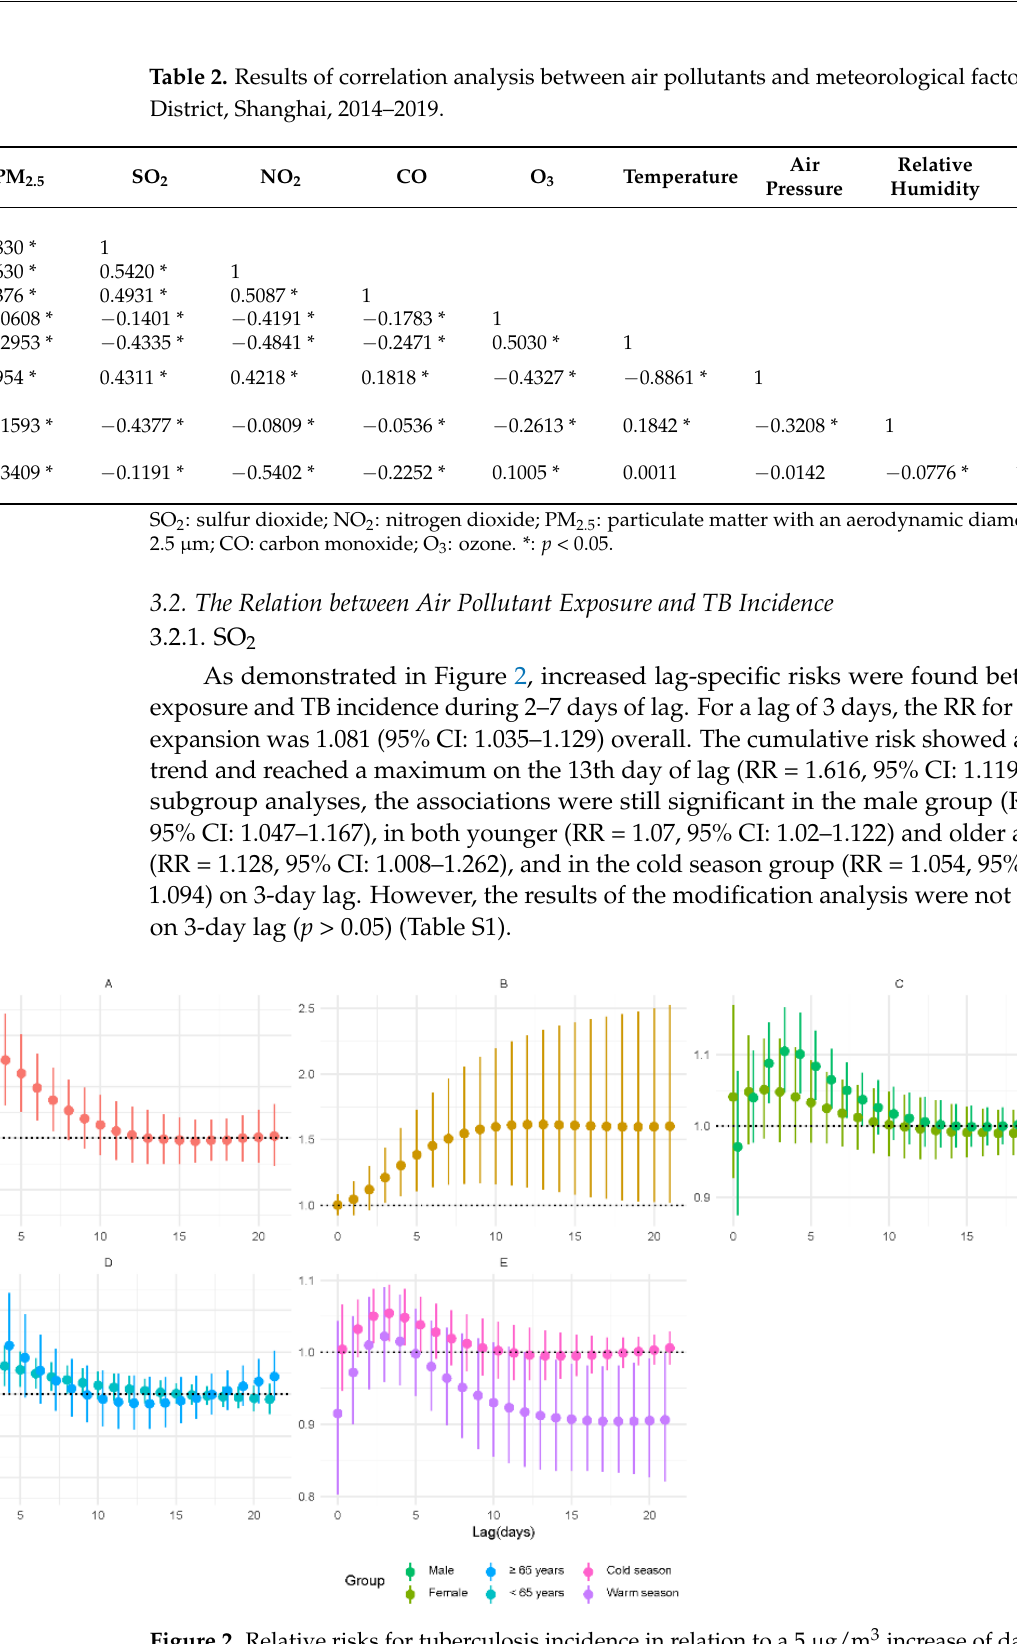
Figure 2. Relative risks for tuberculosis incidence in relation to a 5 µ g/m 3 increase of daily average concentrations of sulfur dioxide (SO 2 ). ( A ) Lag-specific RRs; ( B ) cumulative RRs; ( C ) stratified analysis by gender; ( D ) stratified analysis by age; ( E ) stratified analysis by season.